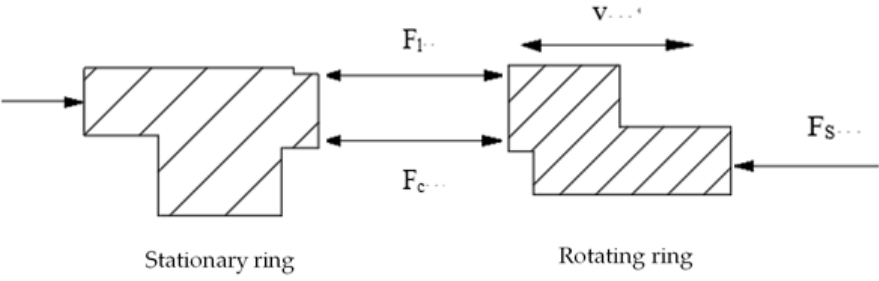
Figure 8. Axial dynamic model of mechanical seal.